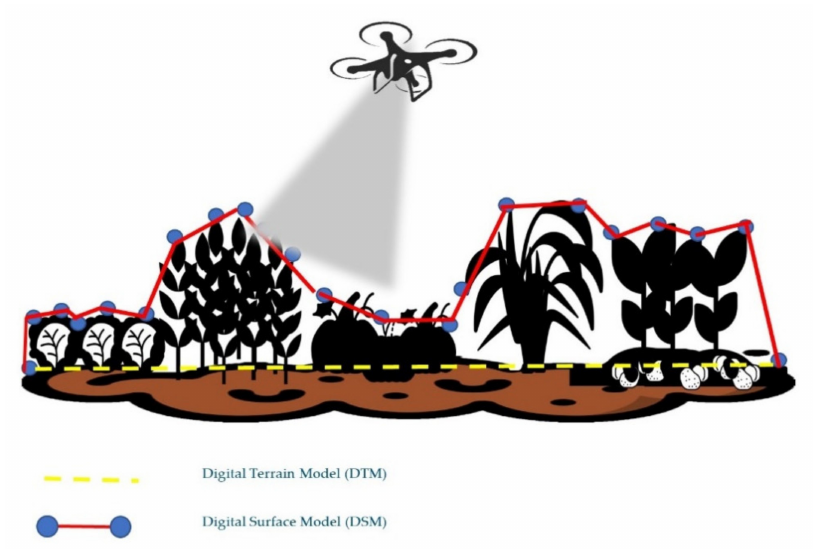
Figure 4. Canopy height model (CHM) extracted from difference between DSM and DTM. The DTM needs to be derived for the field without